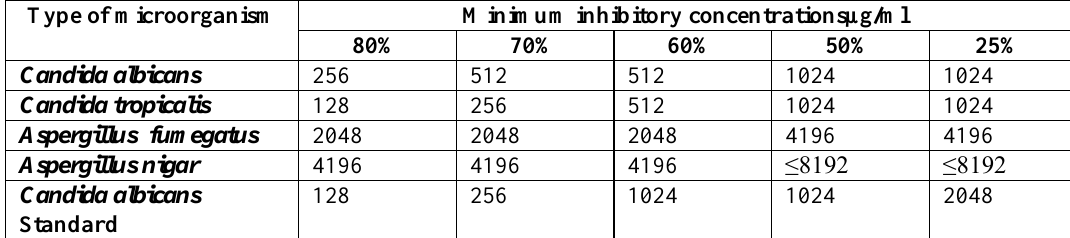
Table (5) - Minimum Inhibitory Concentrations µg/ml of Punica granatum (Pomegranate) Peels Water Extract of Different Concentrations Type of microorganism